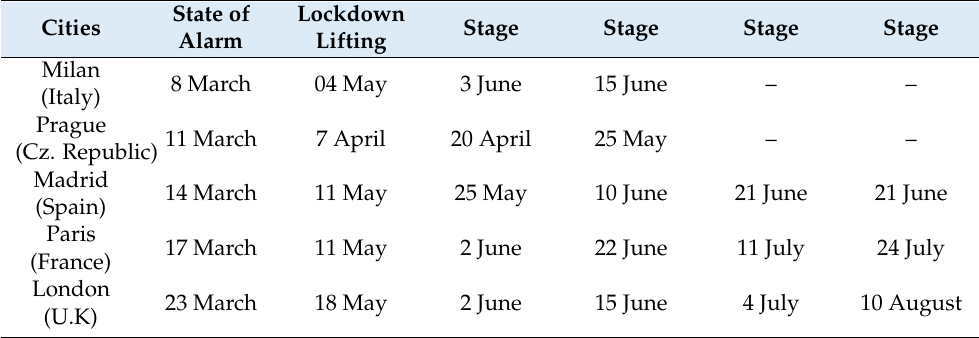
Table 1. State of alarm and different stages during lockdown. Source: Own elaboration.